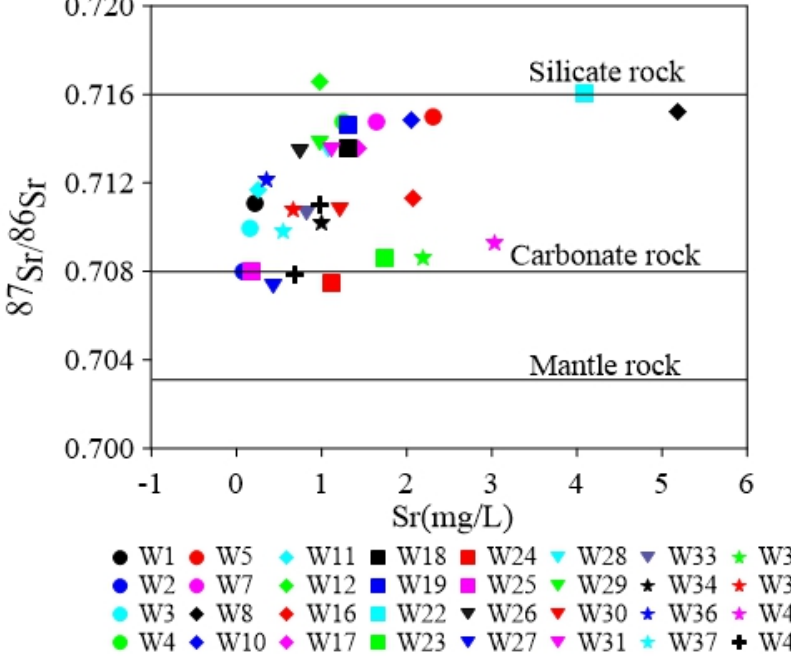
Figure 5. Strontium isotopic composition of 43 hot springs in XSHF.